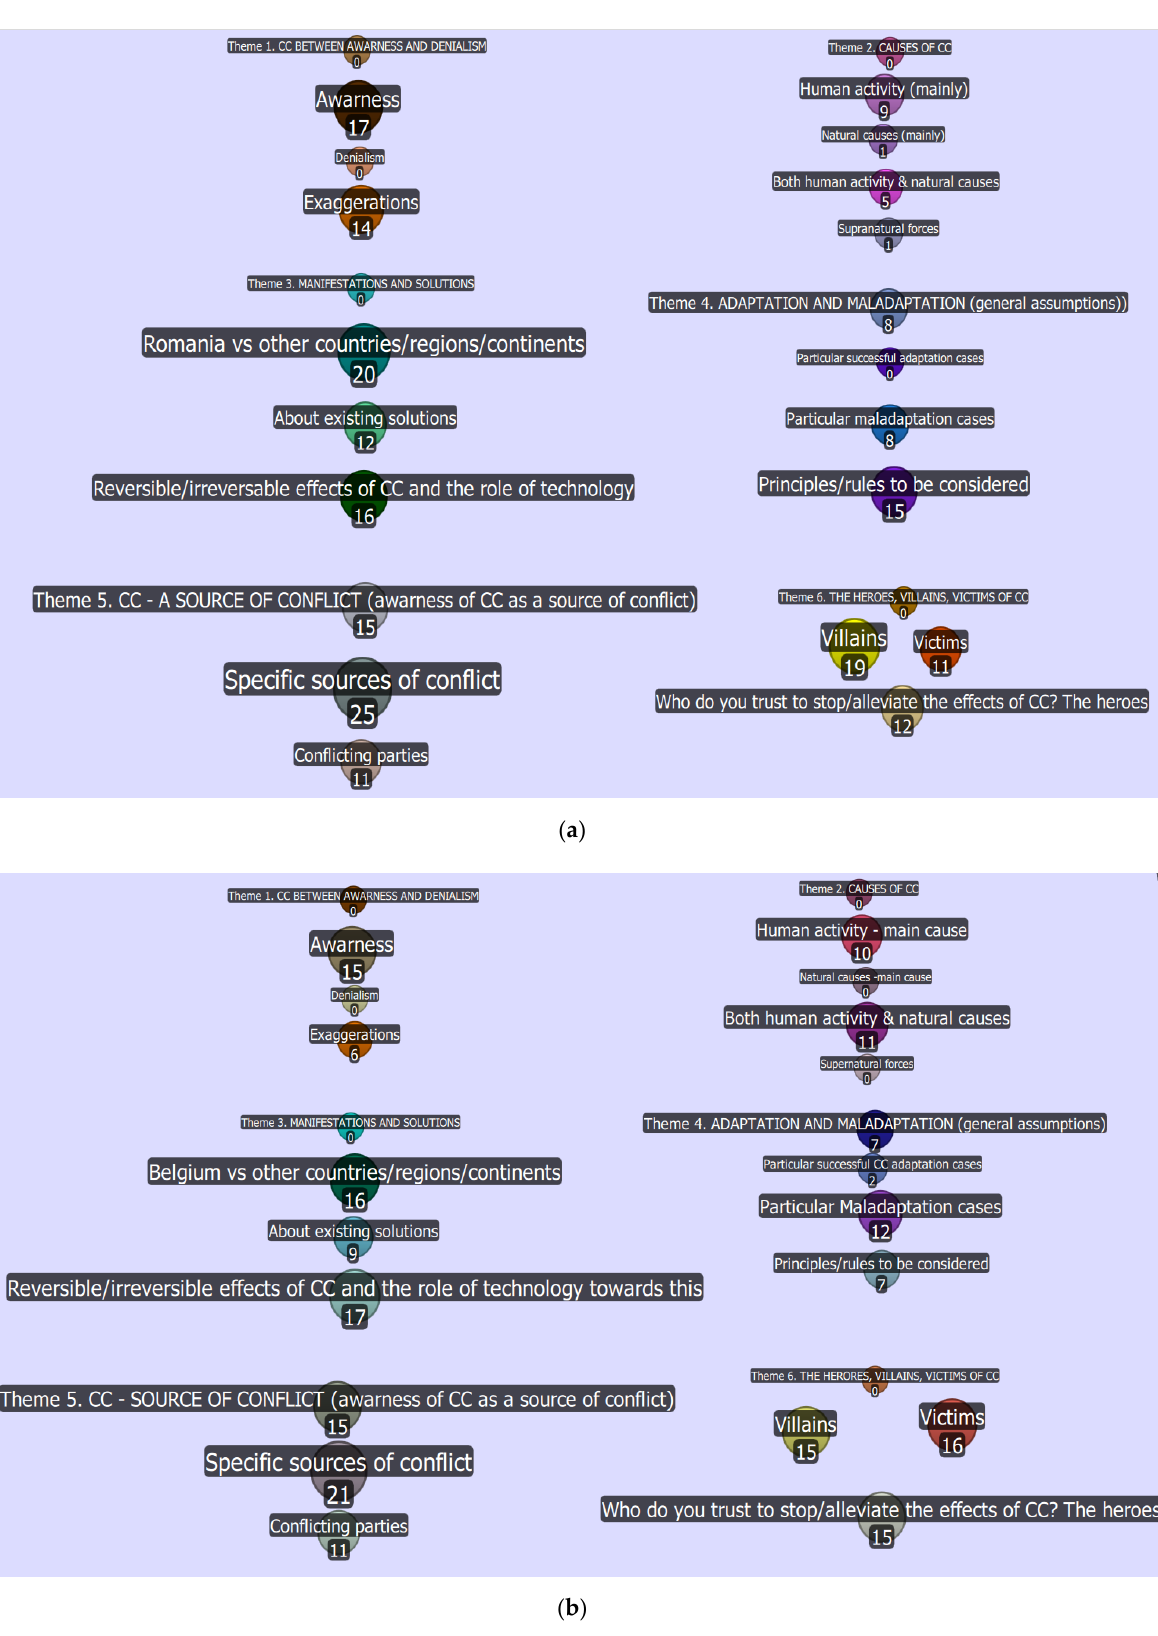
Figure 1. ( a , b ). The matrix of the six science-based climate change topics (the “Quirks”) and their subtopics (generated in Quikos software 2.4.1). ( a ) Romanian participants. ( b ) Belgian